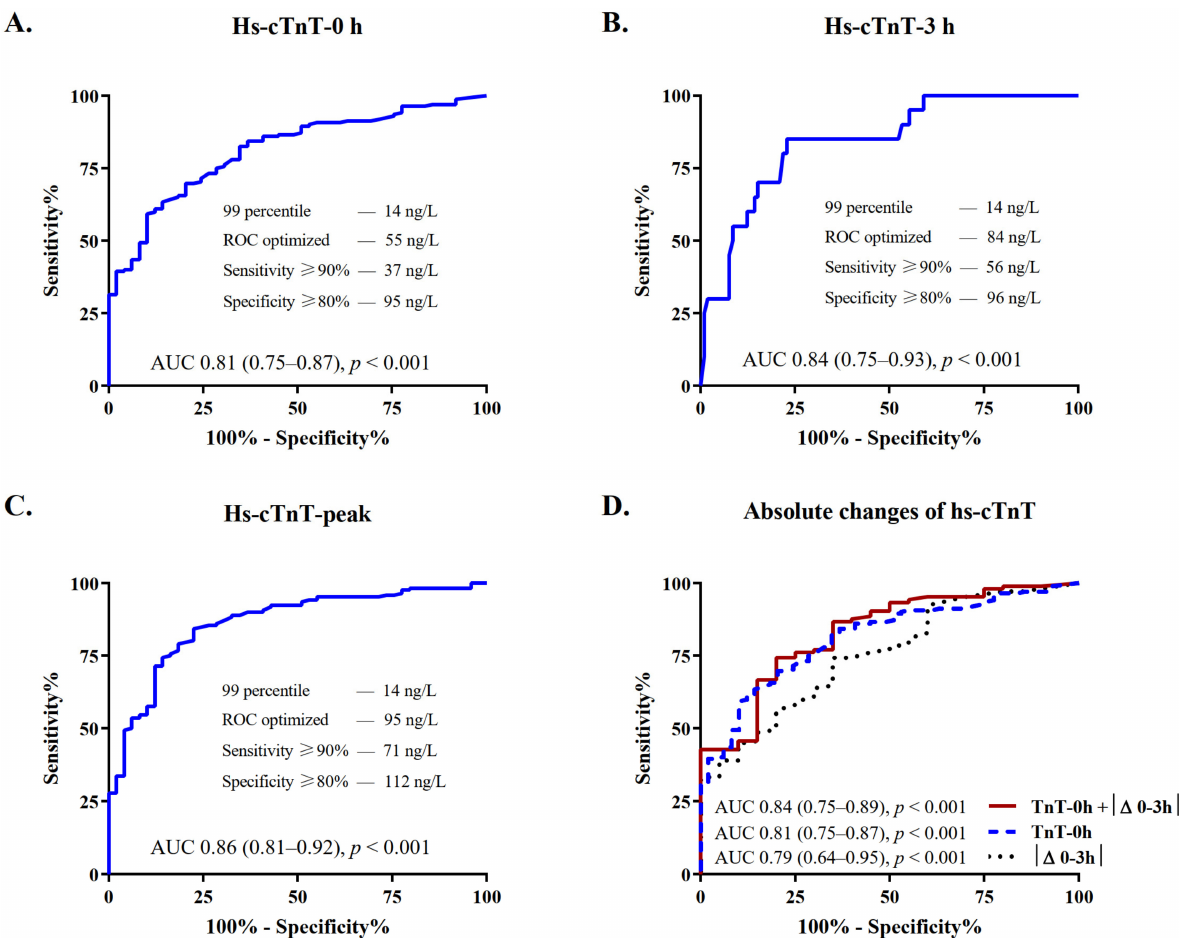
Figure 3. Diagnostic performance of hs-cTnT at serial sampling in patients with severe CKD. Depicted are ROCs and AUCs with 95% confidence intervals (CI) and predefined levels of sensitivity and specificity, describing the performance of the hs-cTnT assay for the diagnosis of NSTE-ACS requiring revascularization at ( A ) presentation, ( B ) 3 h, and ( C ) peak prior to angiography. ( D ) Depicts the improvement of the discrimination power of hs-cTnT at presentation when combined with absolute 3 h changes as compared to each of these variables alone. AUC, area under the receiver operating characteristic curve; CKD, chronic kidney disease; hs-cTnT, high-sensitivity cardiac troponin T; ROC, receiver-operating characteristic